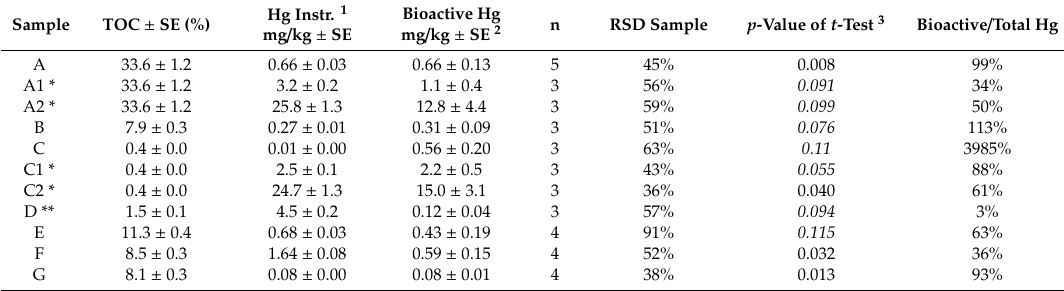
Table 1. Detailed values and their statistics for mercury content determined using laccase extraction and bioreporter. t -test compared the significance of the value compared to